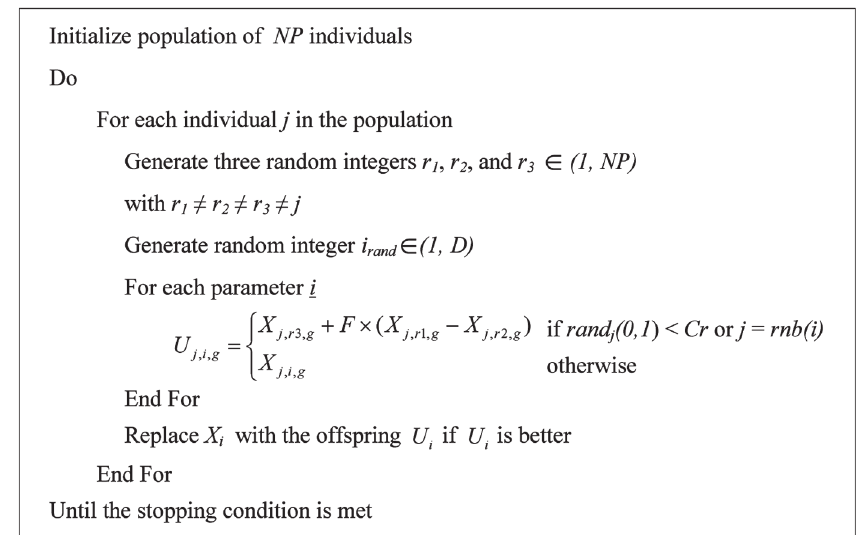
Fig. 2. Differential Evolution optimization